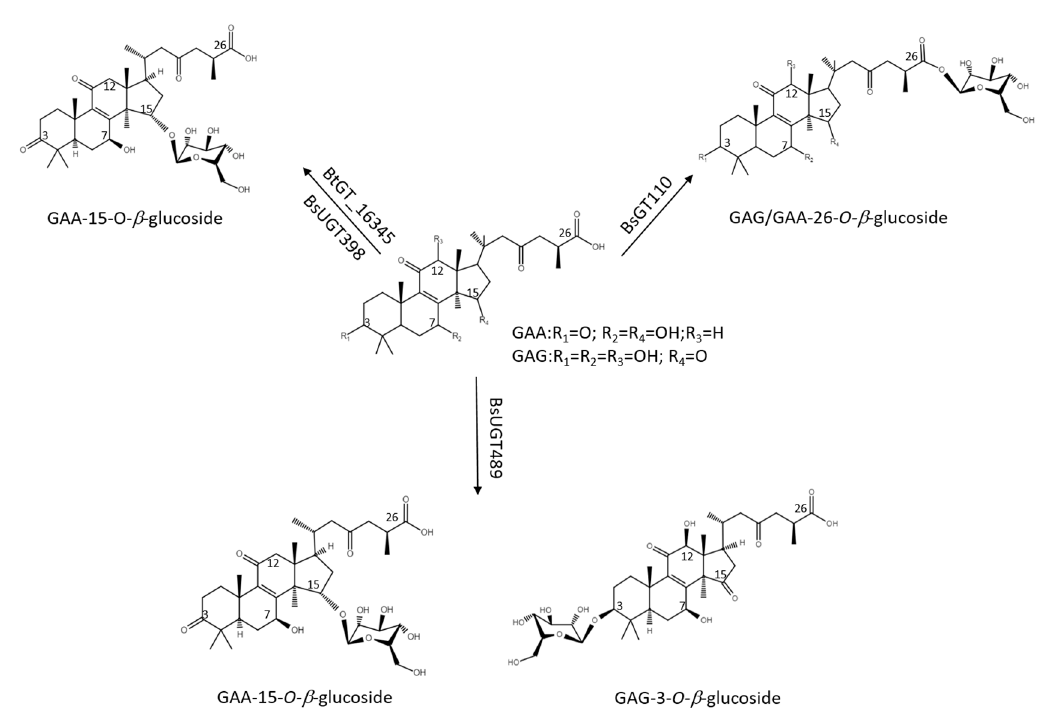
Figure 5. The glycosylation of GAA and GAG by the four Bacillus GTs.